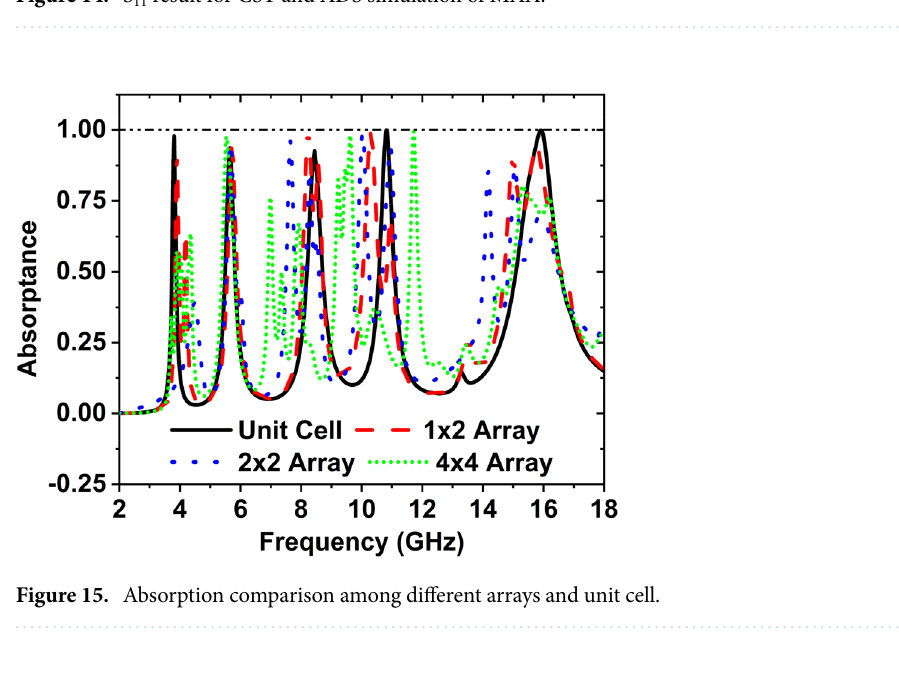
Figure 14. S 11 result for CST and ADS simulation of MAA.